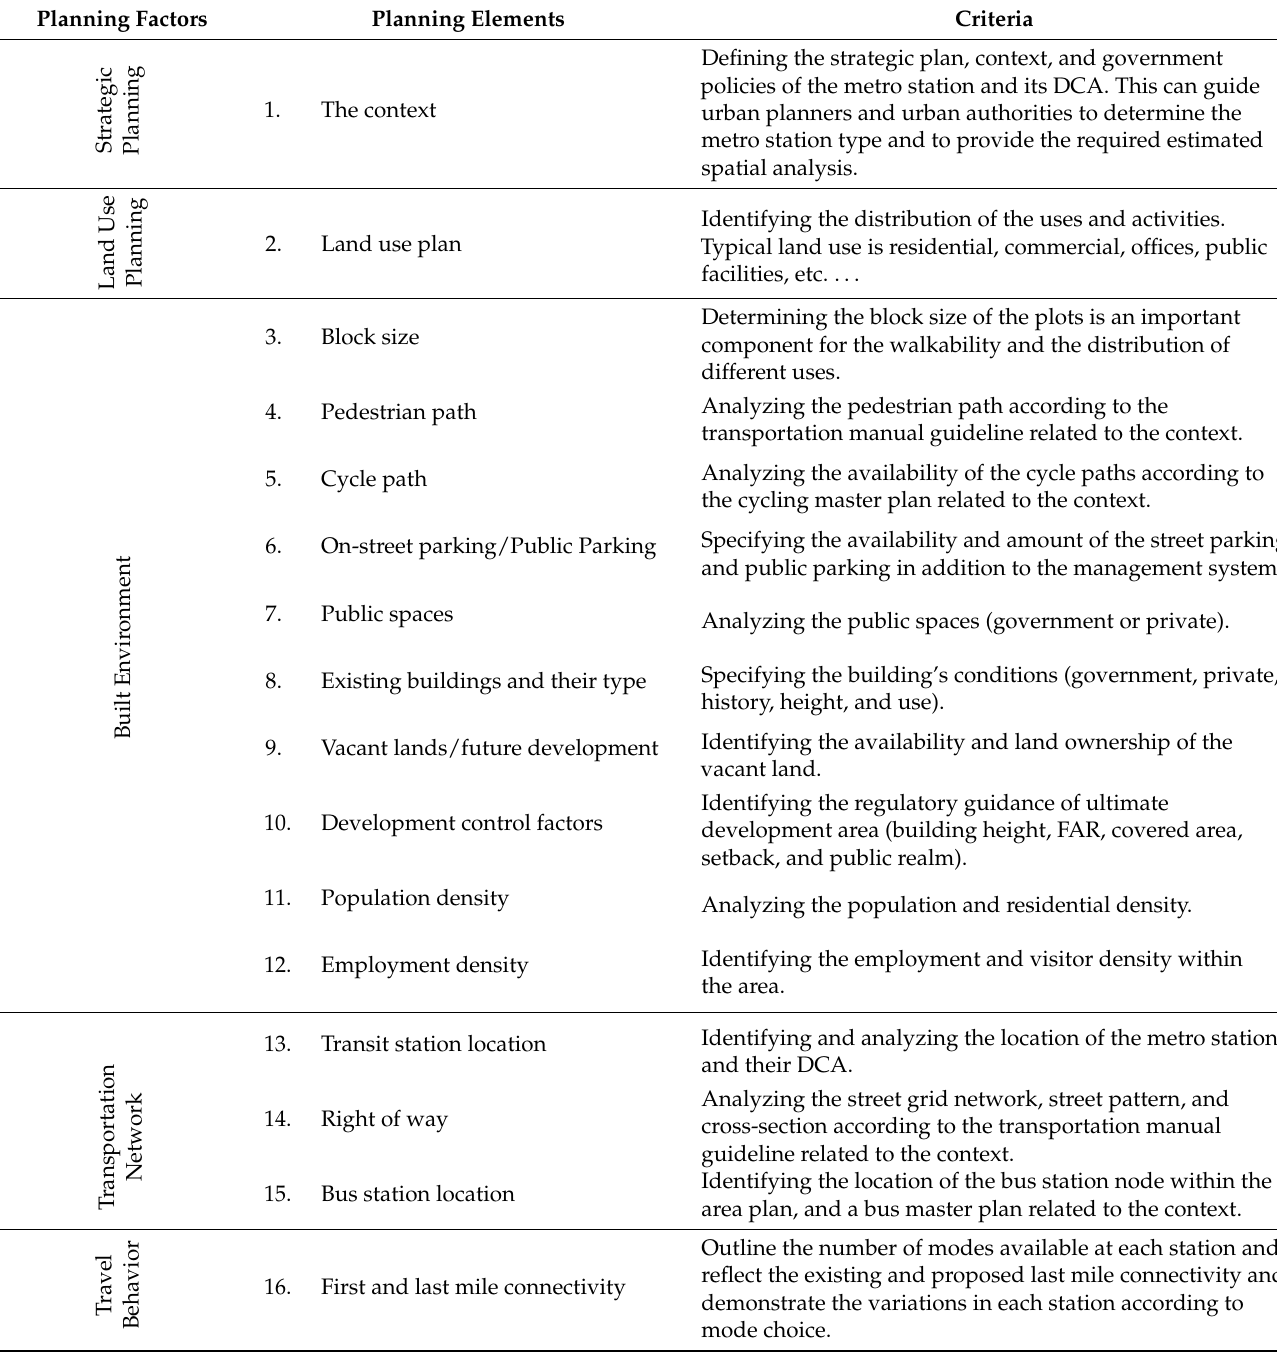
Table 3. Planning factors versus planning